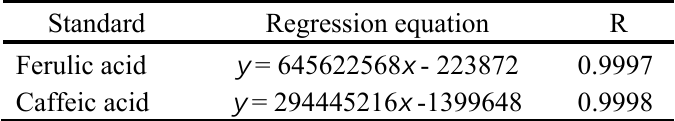
Table 3. The calibration curve and R values of caffeic acid and ferulic acid.